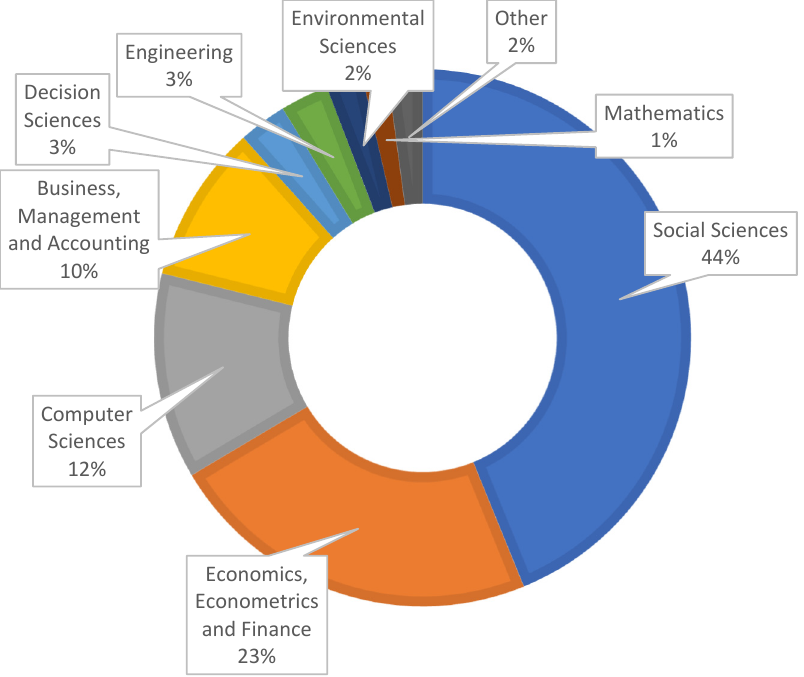
Figure 8. Documents by area of subject.